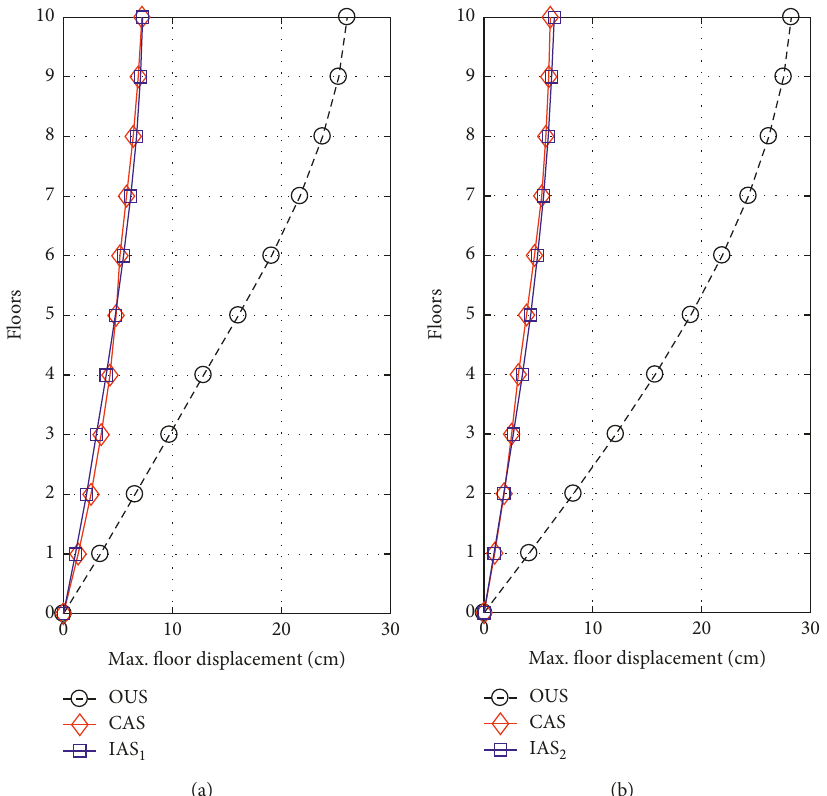
Figure 5: Comparative results of maximum floor displacements among OUS, IAS, and CAS against El Centro earthquakes. (a) Building 1. (b) Building